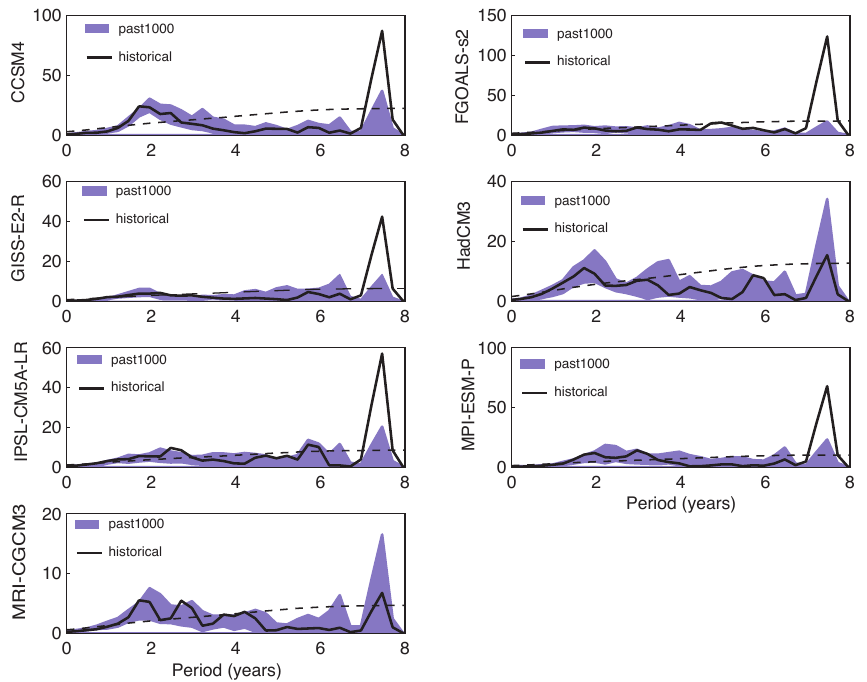
Figure 4. Global mean NINO3.4 power spectrum (K 2 /unit frequency, black) of Last Millennium simulations, relative to the red-noise (AR(1)) benchmark (dashed), for the multi-model mean (MMM) and each model analysed. The historical simulation is shown in black and the 5th–95th percentile range across the Last Millennium shown by purple envelope, calculated using 100-year epochs. Spectral power was calculated using a Morlet wavelet of degree